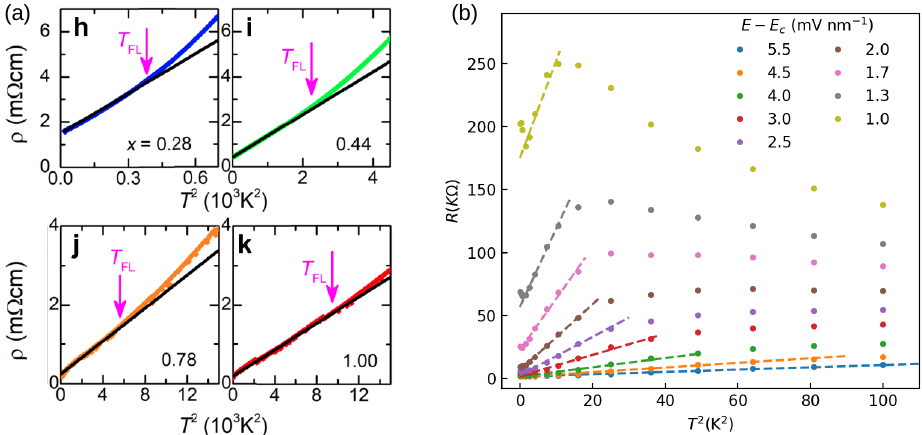
Figure 5. Fermi liquid behaviour at low temperatures, for ( a ) Mott organic material κ − [ (BEDT-TTF) ] 2 Cu 2 (CN) 3 [44] and ( b ) MoTe 2 /WSe 2 moiré bilayers (Data imported 1 − x (BEDT-STF) x from [21]). Clear ρ = ρ 0 + AT 2 behavior is observed in both cases, up to a temperature scale T FL that seems to decrease linearly towards the metal-insulator transition. The resistivity curves can be collapsed by plotting ρ ( E , T ) / ρ c ( T ) vs. T / T 0 where T 0 ∼ | E − E c | 0.70 ± 0.05 , see Figure 2c. Note that this crossover scale seems to follow both the gap size on the insulator, as well as the destruction of the Fermi liquid on the metallic side.